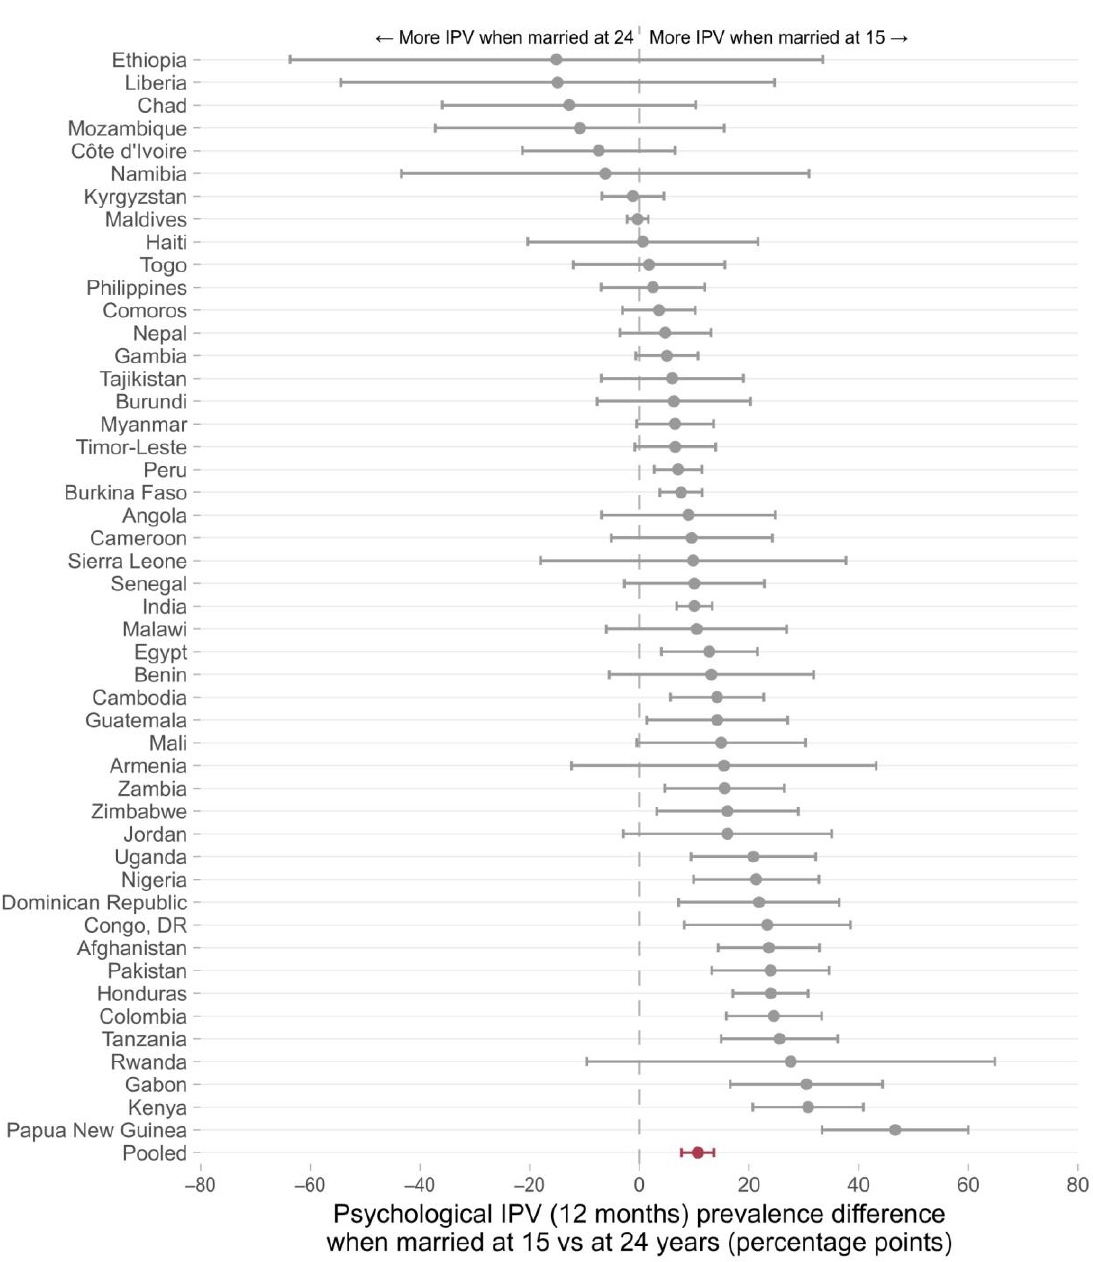
Figure 4. Difference between the average adjusted psychological IPV prevalence among women aged 20-24 years first married at 15 years and at 24 years of age. Individual results for 48 low- and middle-income countries obtained from logistic regression models. The pooled estimate of the prev- alence difference in past year psychological IPV (in red) was 10.6 percentage points (95% CI 7.7 –